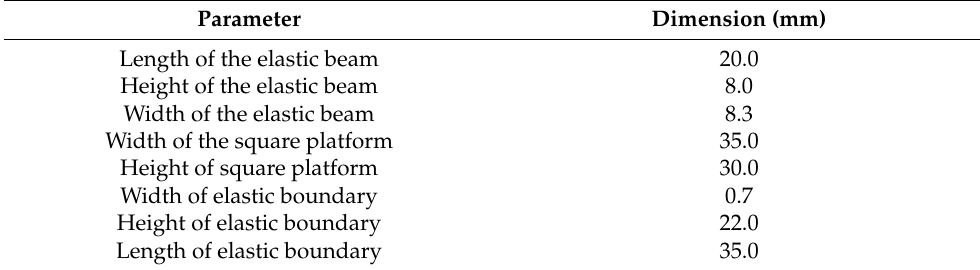
Figure 4. The initial design of the elastic body. Table 2. Initial designs of